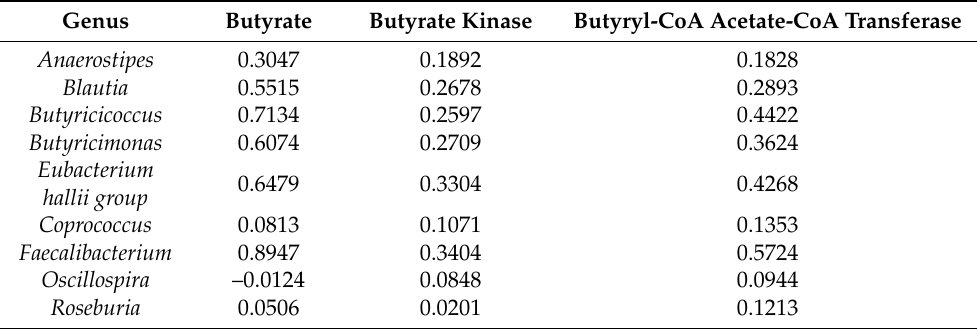
Table 4. Spearman's rank correlation coefficients between butyrate contents and the gene copies of butyrate kinase and butyryl CoA: acetate CoA transferase.